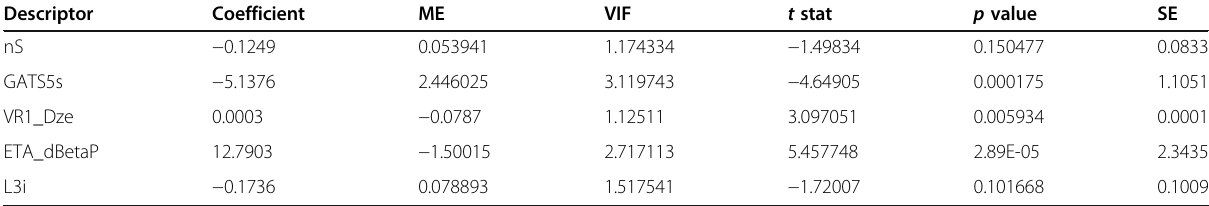
Table 4 Statistical parameters of descriptor